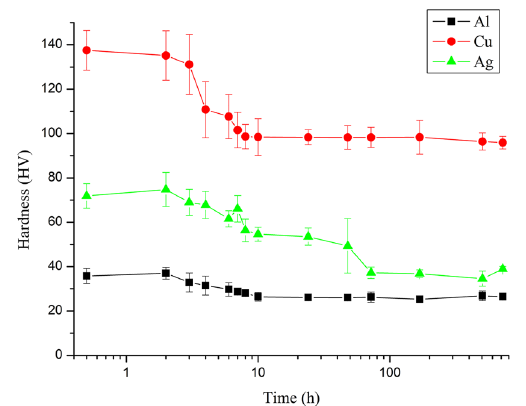
Figure 4. Hardness in function equivalent strain for RT rolled materials.